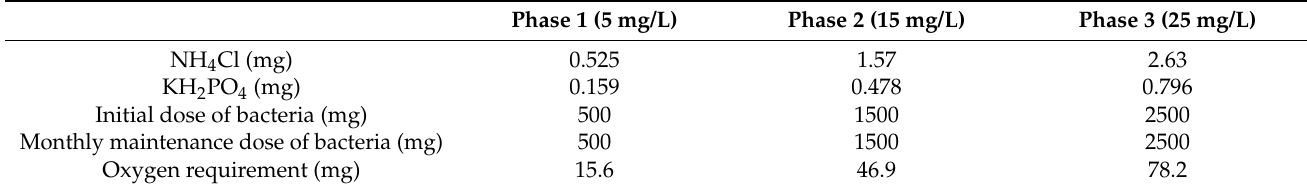
Table 3. Nutrient, bacteria, and oxygen requirements for phase 1, phase 2, and phase 3